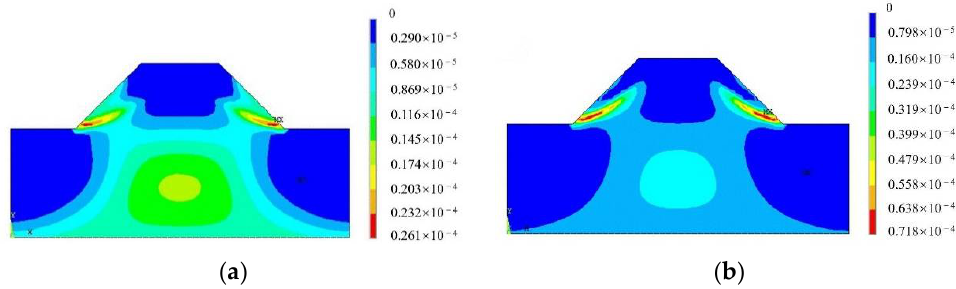
Figure 3. Plastic strain diagram with reduction coefficient of F = 1.4. ( a ) Plain soil slope. ( b ) Fiber soil slope.